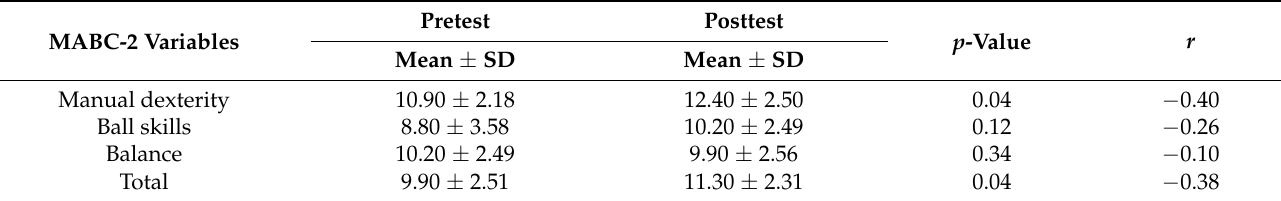
Table 2. Participants’ Motor Competence Scores.